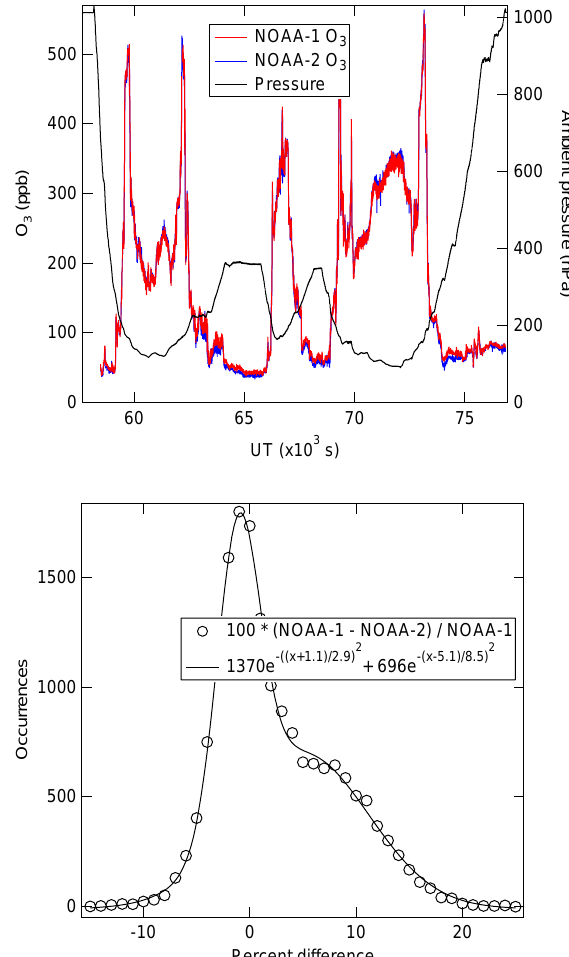
Fig. 9. In-flight intercomparison between the NOAA-1 O 3 and NOAA-2 O 3 instruments while operating onboard the NASA WB- 57F high altitude research aircraft on 11 April 2011 in Houston, TX. Top panel: time series of O 3 mixing ratio data over the approx- imately the 5-h flight along with ambient pressure. The NOAA-2 O 3 data points are averaged to 1 s to match the time resolution of the NOAA-1 O 3 instrument. Bottom panel: probability distribution of the percent difference between NOAA-1 O 3 and NOAA-2 O 3 (100 * (NOAA-1–NOAA-2) / NOAA-1) with a double-Gaussian fit.